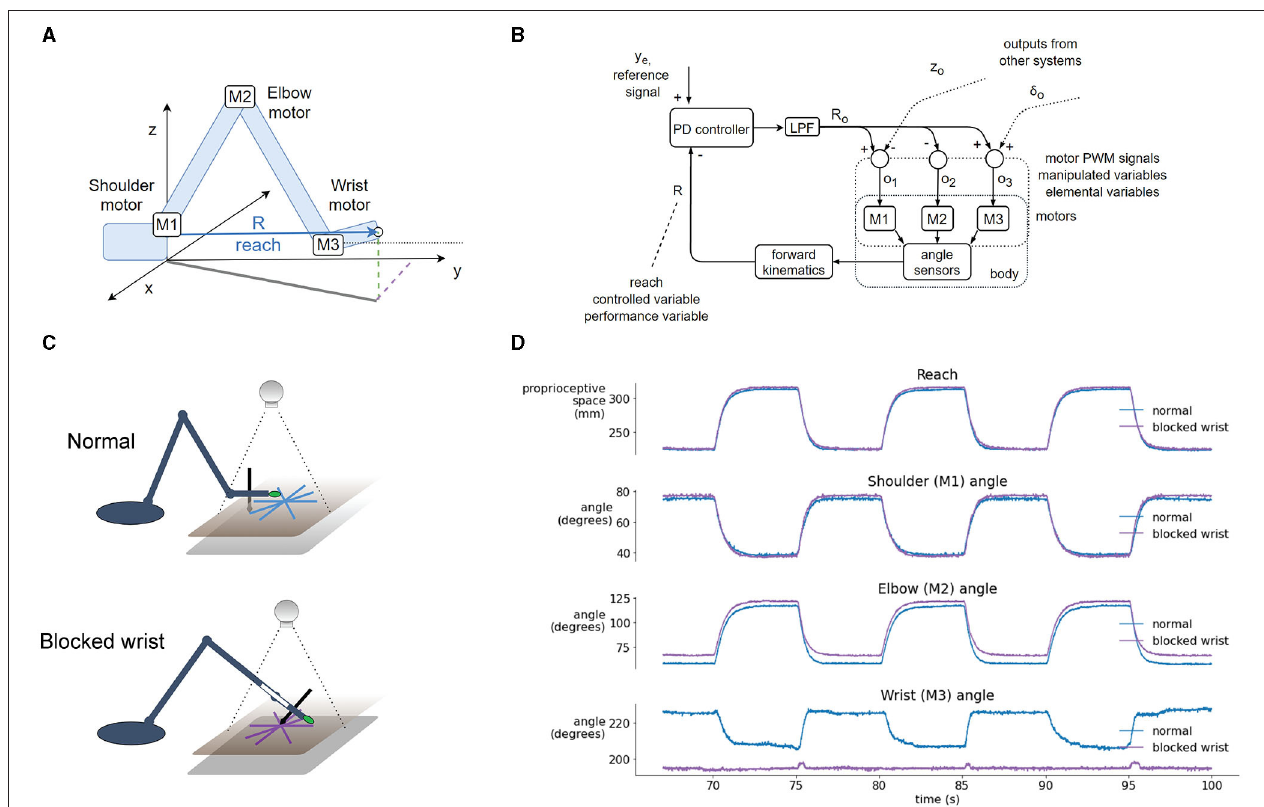
FIGURE 6 | Blocking the wrist is compensated by the reach synergy. (A) Geometric definition of reach— the distance from shoulder base to the tip of the hand, and locations of joint motors. (B) Block diagram of computational and physical processes in the reach synergy, with marked performance and elemental variables. (C) Diagram of the normal and blocked wrist setup. In the normal setup, the wrist moves freely, keeping the hand parallel to the tablet (and the pen perpendicular). In the blocked-wrist setup, the motor of the wrist is not powered, and the wrist is locked at ∼ 180 ◦ to the forearm. (D) Segment of a reaching task with a step reference, comparing the normal and blocked-wrist situation. With the wrist blocked, reach is nearly identical to reach in the normal situation, but shoulder and elbow motors are activated more to compensate. Shoulder and especially elbow angle show differences in both